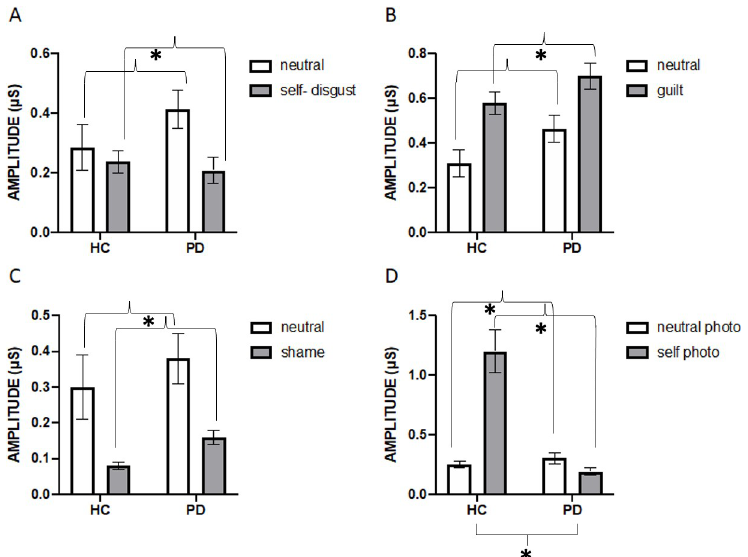
Fig 2. Peak amplitude ( μ S) of the skin conductance response as a function of condition (emotion and neutral) and group (HC = Healthy Controls and PD = Parkinson’s Disease patients). Panels A-C: Physiological responses for self-disgust, guilt and shame narration paradigms, respectively. Panel D: Physiological responses for the photo paradigm (self-disgust induction). Error bars represent standard error and asterisk significant differences (p <